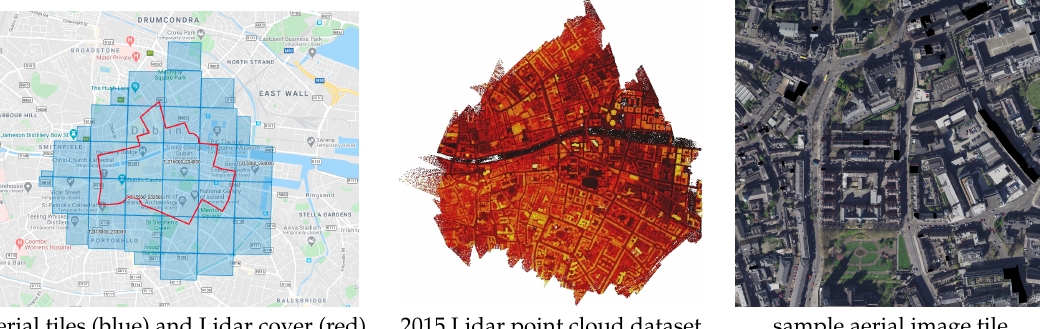
Figure 1. IM2ELEVATION pipeline: from single view aerial imagery to building heights/Digital Surface Model (DSM). Light detection and ranging (Lidar) point cloud is used solely at training phase.